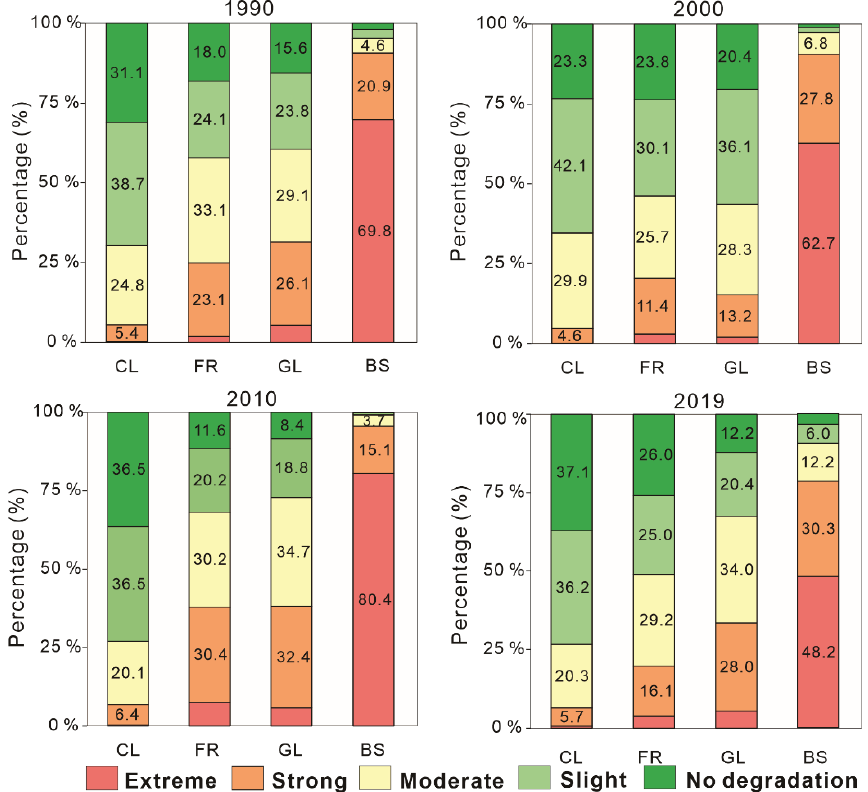
Figure 15. Percentage graphs showing the proportion of each land degradation level in different land use types. Extreme: extreme degradation; Strong: strong degradation; Moderate: moderate degradation; Slight: slight degradation.CL: cropland; FR: forest; GL: grassland; BS: bare